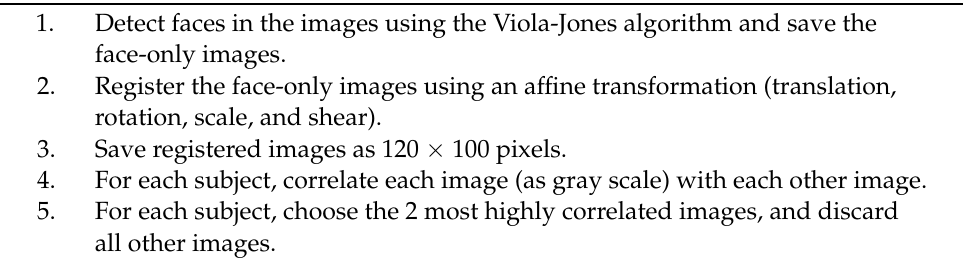
Algorithm 2: Steps in the preparation of images for facial